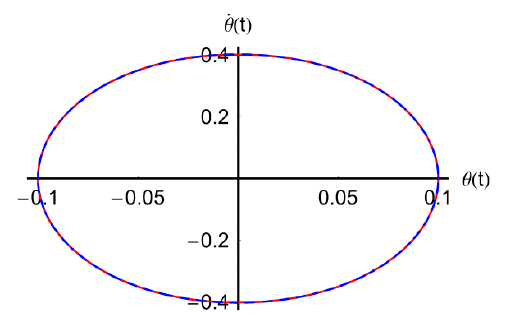
Figure 21. Phase plane for A = 0.4, L = 0.6. Figure 3. Phase plane for A=0.1, a=0.2, L=0.6 _____ numerical_ _ _ _approximate solution (39). Figure 3. Phase plane for A = 0.1, a = 0.2, L = 0.6